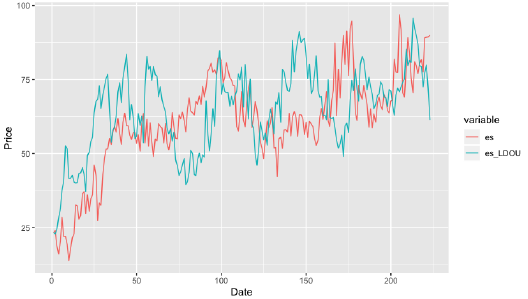
Figure 10. Simulation Result of LDOU model on energy-switching data.